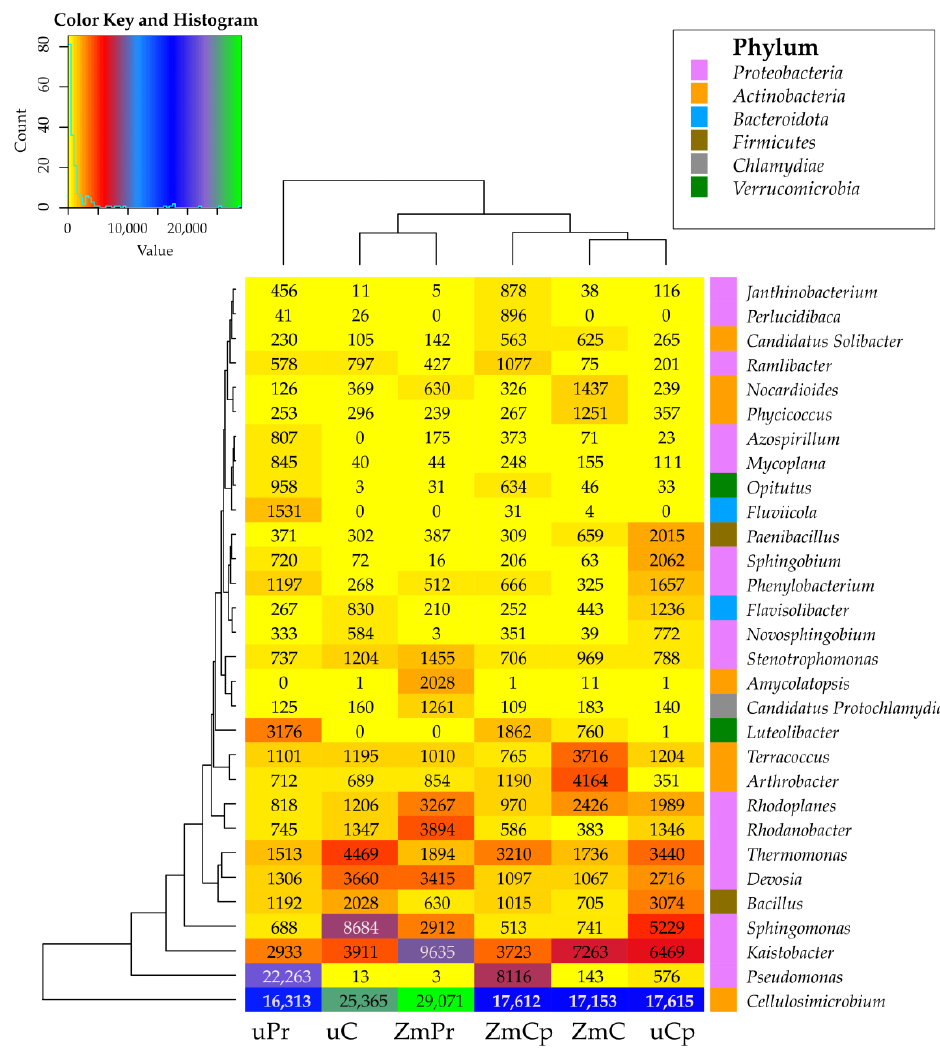
Figure 6. The relative abundance of the dominant bacterial genus in the soil. uC — contaminated unsown soil; uPr — sown soil contaminated with permethrin; uCp — sown soil contaminated with cypermethrin; ZmC — uncontaminated soil sown with Zea mays ; ZmPr — soil sown with Zea mays contaminated with permethrin; ZmCp — soil sown with Zea mays contaminated with cypermethrin. Despite changes in OTU abundance of the mentioned genera, the Venn diagram proved relative stability of bacterial communities in the soil, regardless of its utilization mode and contamination with permethrin and cypermethrin, as indicated by the very rich core bacteriome consisting of as many as 25 genera of the 30 identified ones (Figure 7).